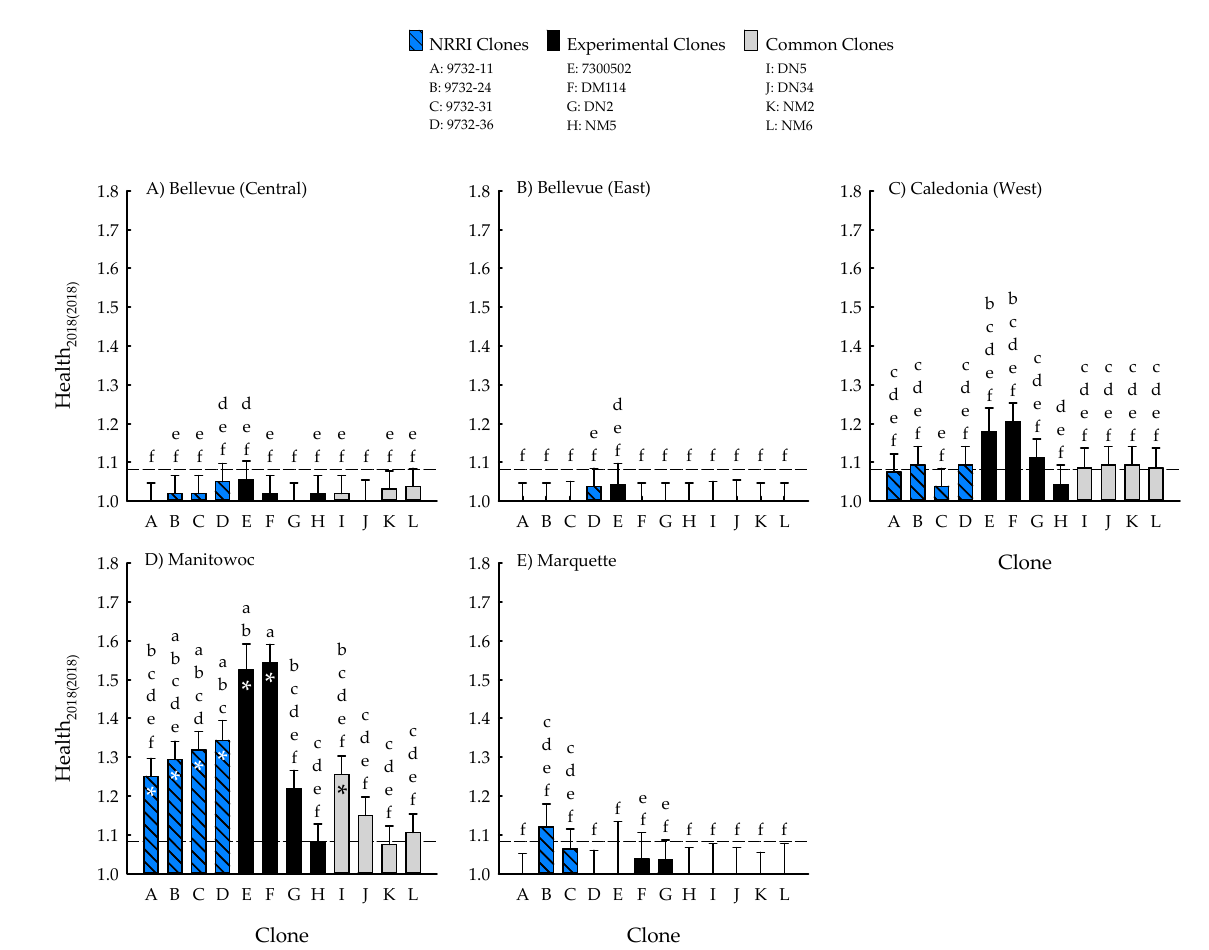
Figure 3. Tree health ( ± one standard error) determined after the 2018 growing season of twelve poplar clones tested in five phytoremediation buffer systems (i.e., phyto buffers) ( A – E ) established in 2018 (i.e., the 2018 buffer group) in the Lake Superior watershed of the Upper Peninsula of Michigan, USA and the Lake Michigan watershed of eastern Wisconsin, USA. The dashed line represents the overall mean, and asterisks indicate means different than the overall mean at P < 0.05. Bars with different letters across all buffer × clone combinations are different at P < 0.05. See Materials and Methods for complete tree health definitions (1 = optimal health, 2 = good health, 3 = moderate health, 4 = poor health, and 5 = dead). Differences among buffer and clone main effects were significant for first-year health of the 2019 buffer group trees (HEALTH 2019(2019) ) ( P Buffer < 0.0001; P Clone = 0.0159), yet the buffer × clone interaction governed health ( P = 0.0036) (Table S2). HEALTH 2019(2019) ranged